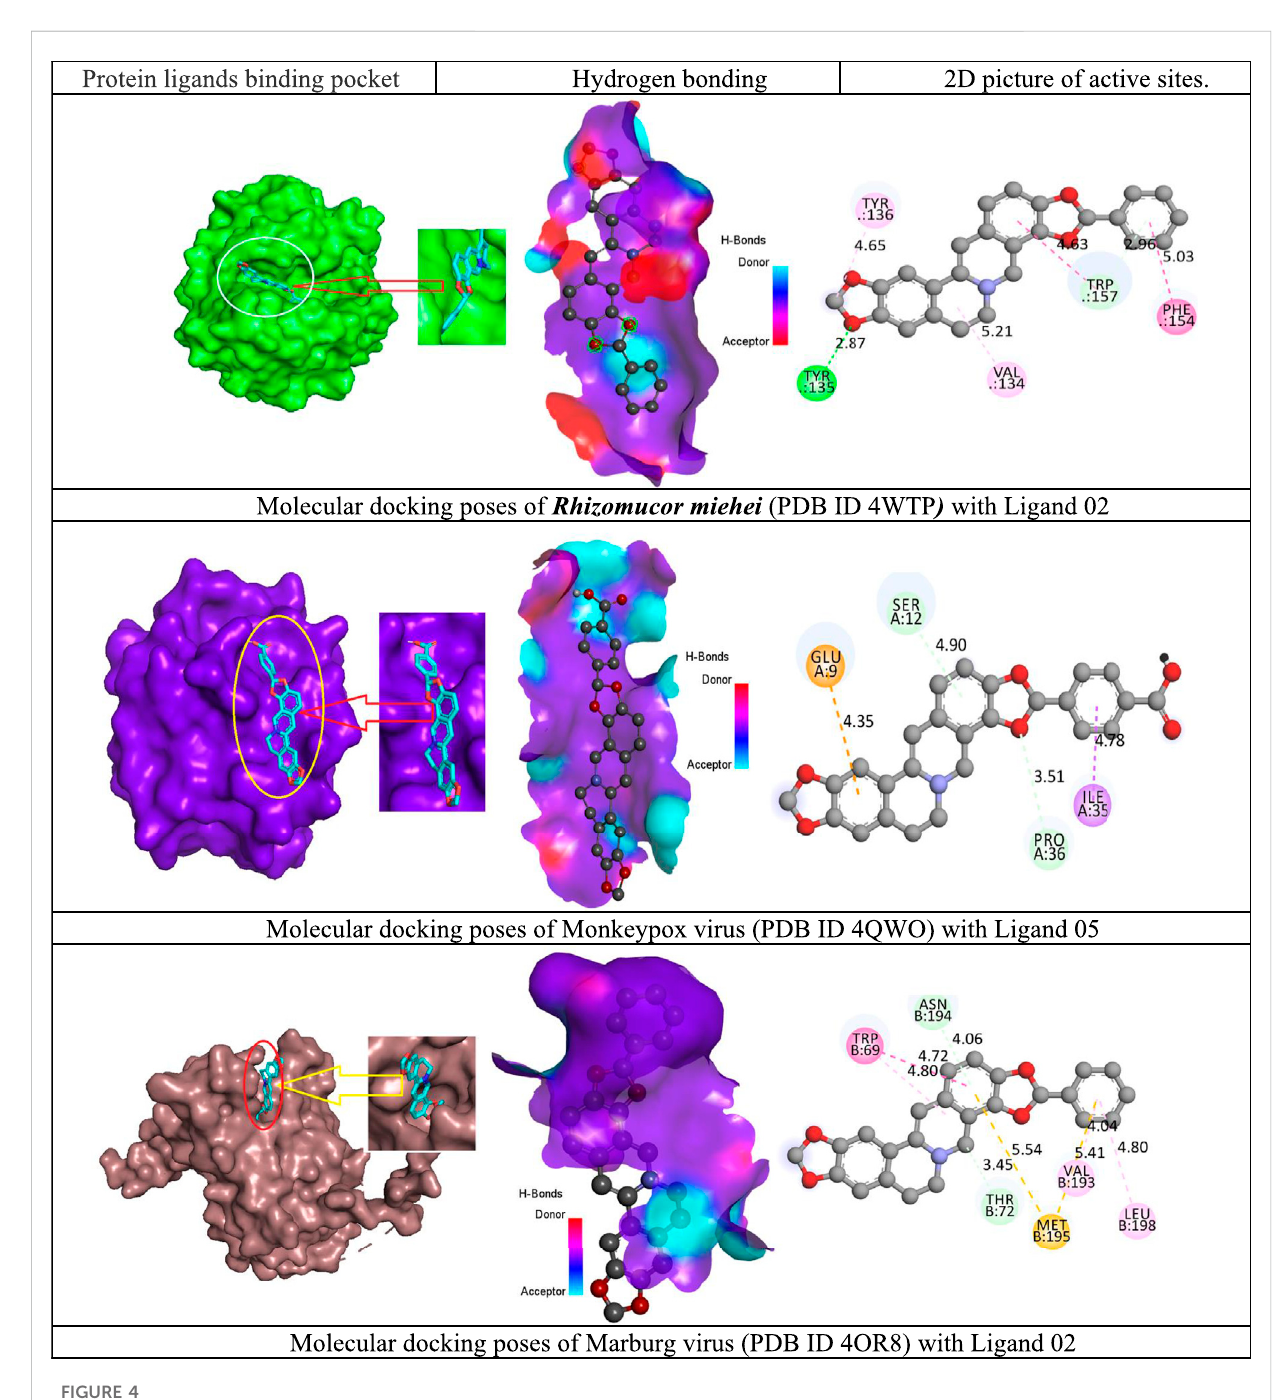
Marburg virus disease.